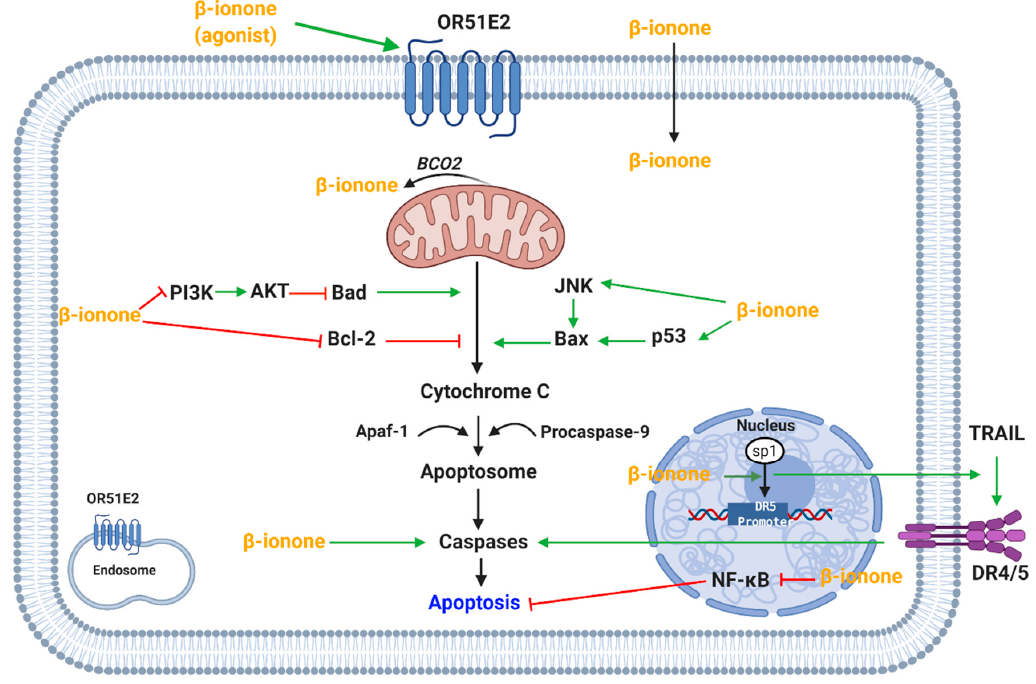
Figure 3. A proposed mechanism of β -ionone modulating pro-apoptotic and anti-apoptotic pathways.